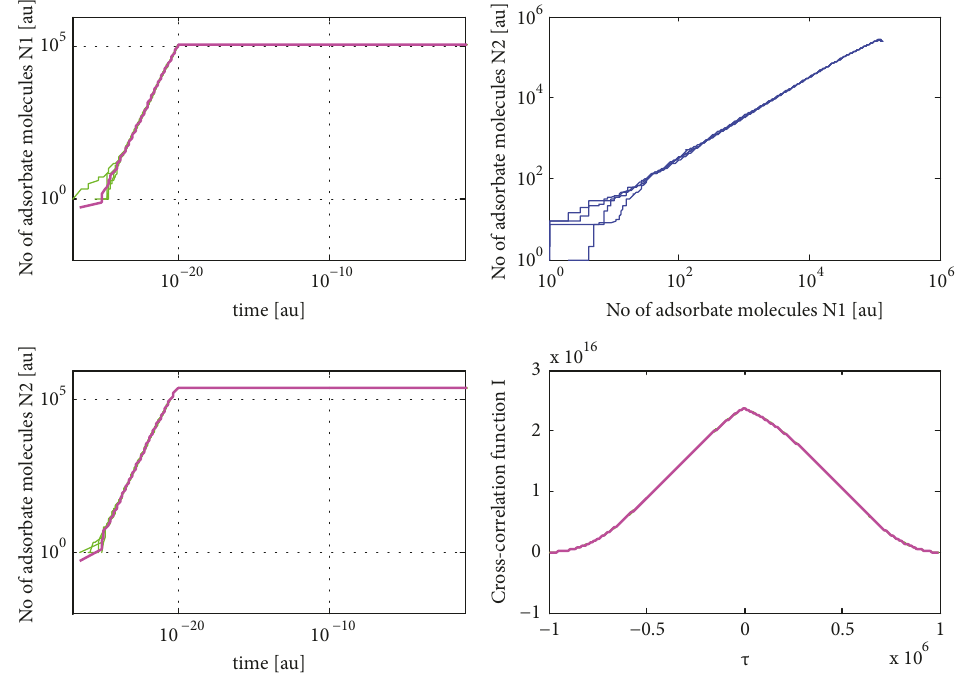
Figure 2: Time evolutions of the number of adsorbed molecules (left), phase space (up right), and the corresponding cross-correlation function (down right), fictive mixture, clean surface at the